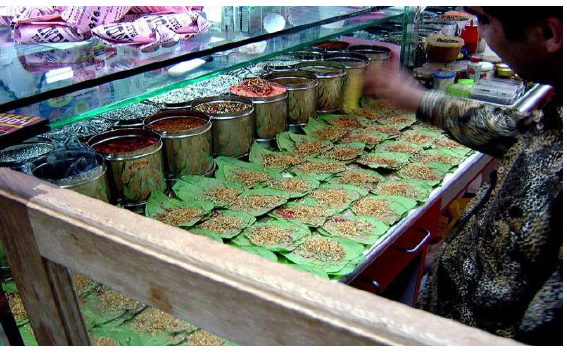
Figure 14. Stand where various kinds of paan are produced and offered for